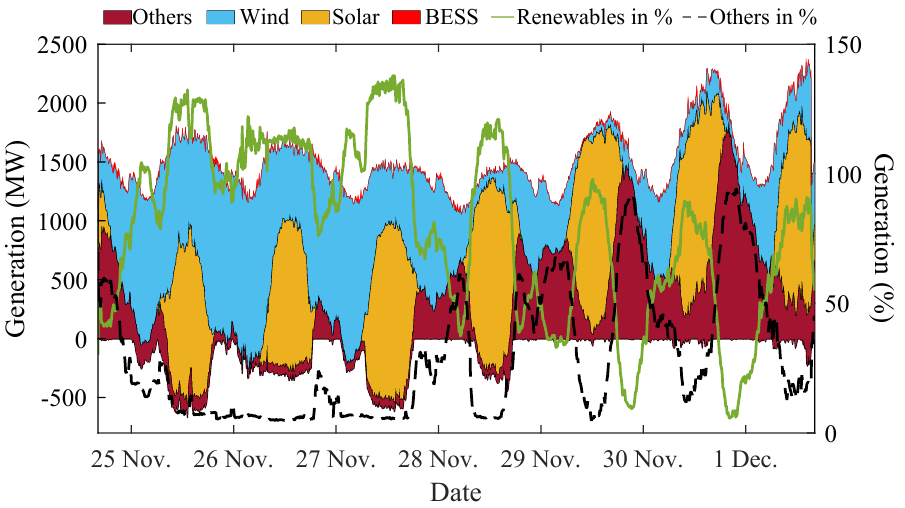
Figure 7. Generation mix in South Australia for a 7-day window. High levels of variable renewable energy requires a portfolio of solutions to supply the demand (plot drawn with data from [60]).